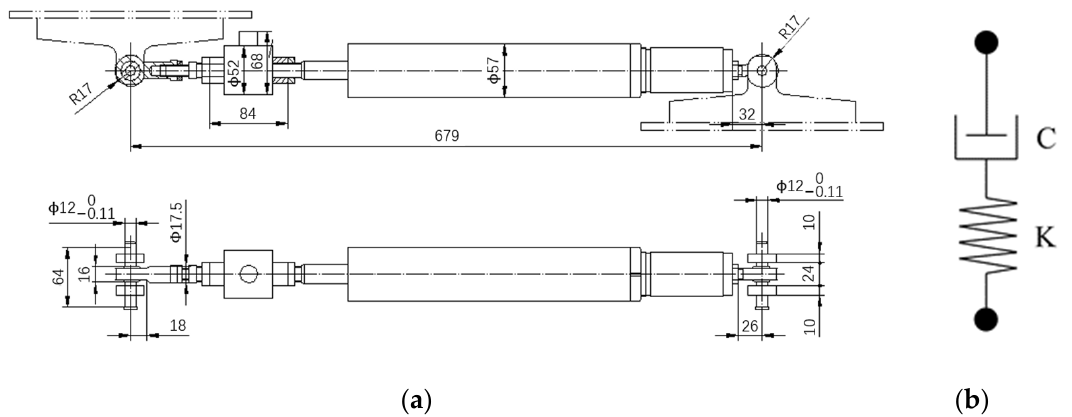
Figure 14. Exponential Maxwell damper: ( a ) actual design (unit: mm); ( b ) theoretic model.